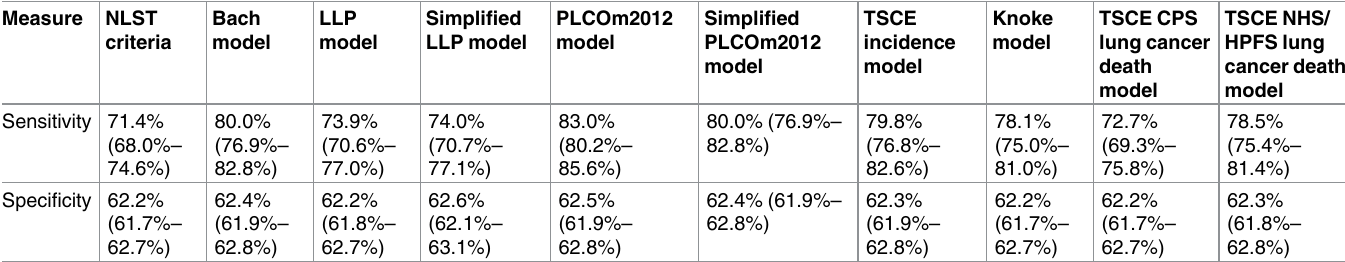
Table 4. Sensitivitiesand specificitiescorresponding to the suggested risk thresholds for the investigatedrisk prediction models and the National Lung Screening Trial criteria for 6-y lung cancer incidence in the Prostate, Lung, Colorectal and Ovarian CancerScreening Trial chest radiography